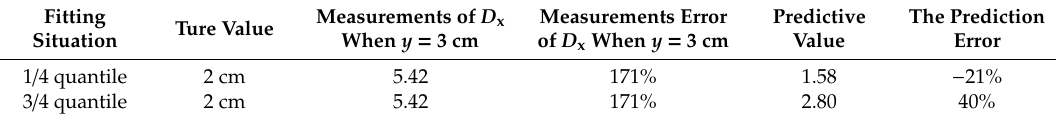
Table 1. Prediction results and error table.